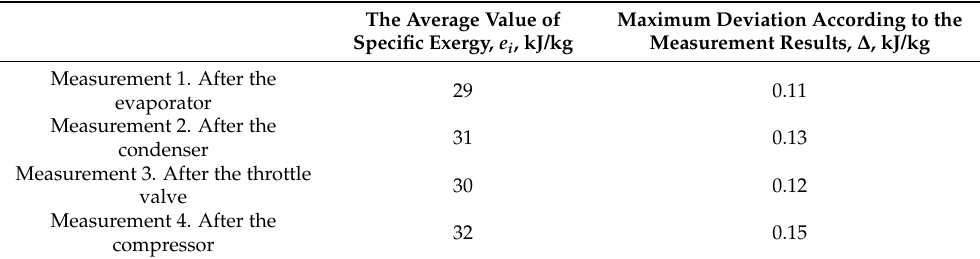
Table 7. Results of direct measurements and